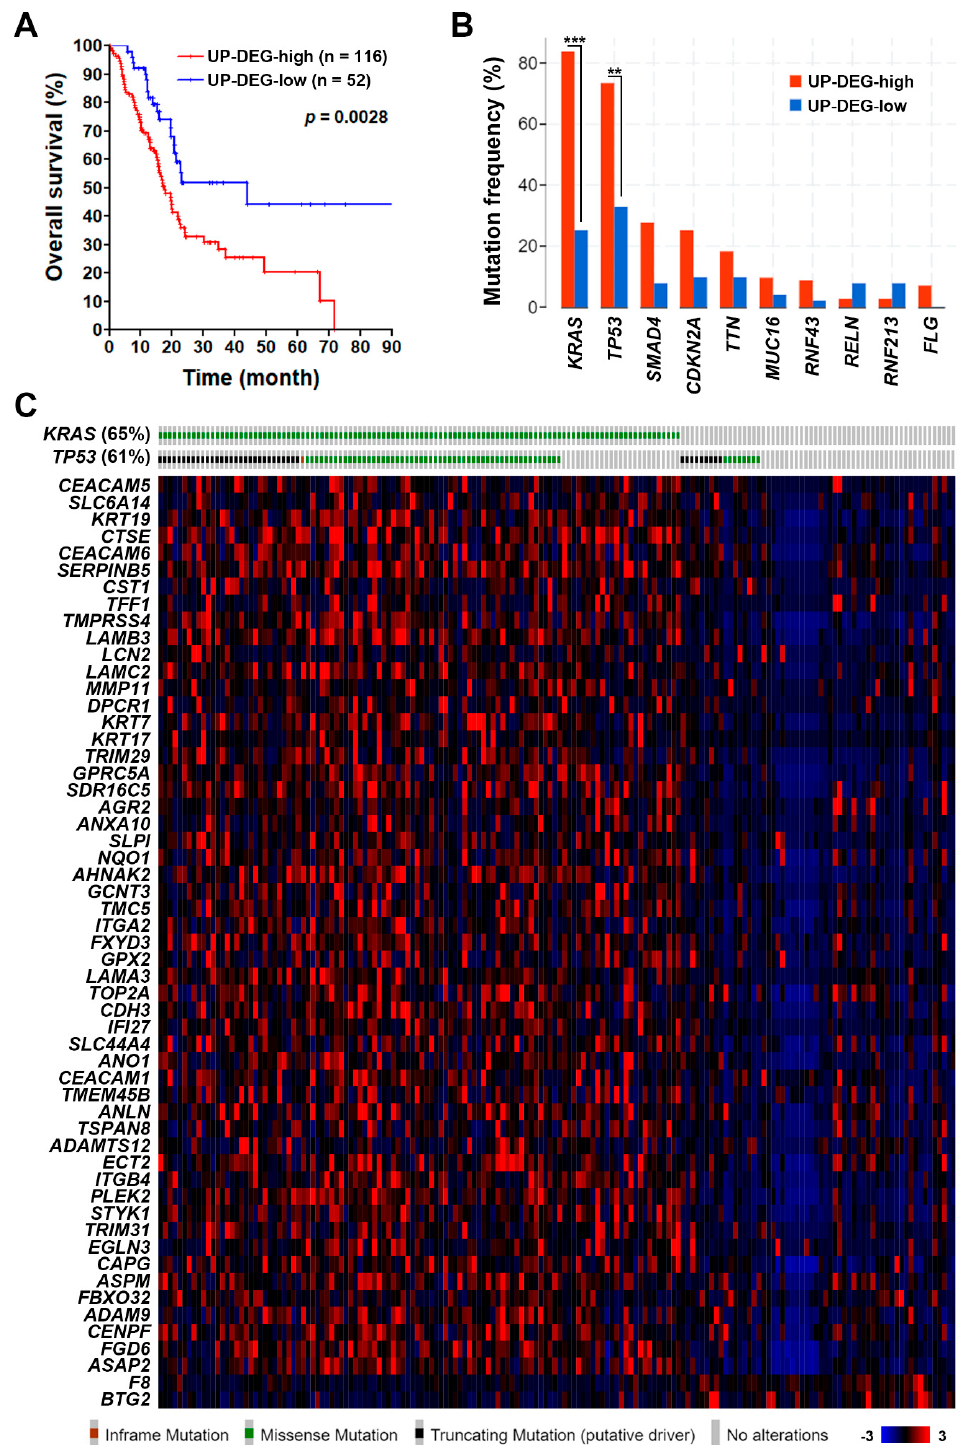
Figure 4. The association of pancreatic ductal adenocarcinoma gene signature with patients’ overall survival and gene mutations. ( A ) A Kaplan–Meier plot shows the association of 53 common upregulated genes (UP-DEG) with PDAC patients’ overall survival. The term “UP-DEG-high” indicates patients with higher mRNA expression (z-score > 2) of any one of the 53 common upregulated genes. The remaining patients are classified as “UP-DEG-low” cases. ( B ) The association of 53 common upregulated genes (UP-DEG) with PDAC patients’ gene mutation status. ( C ) A heat map shows the association of PDAC gene signature with KRAS and TP53 mutations. Inset at bottom right: a gradient color key shows the related gene